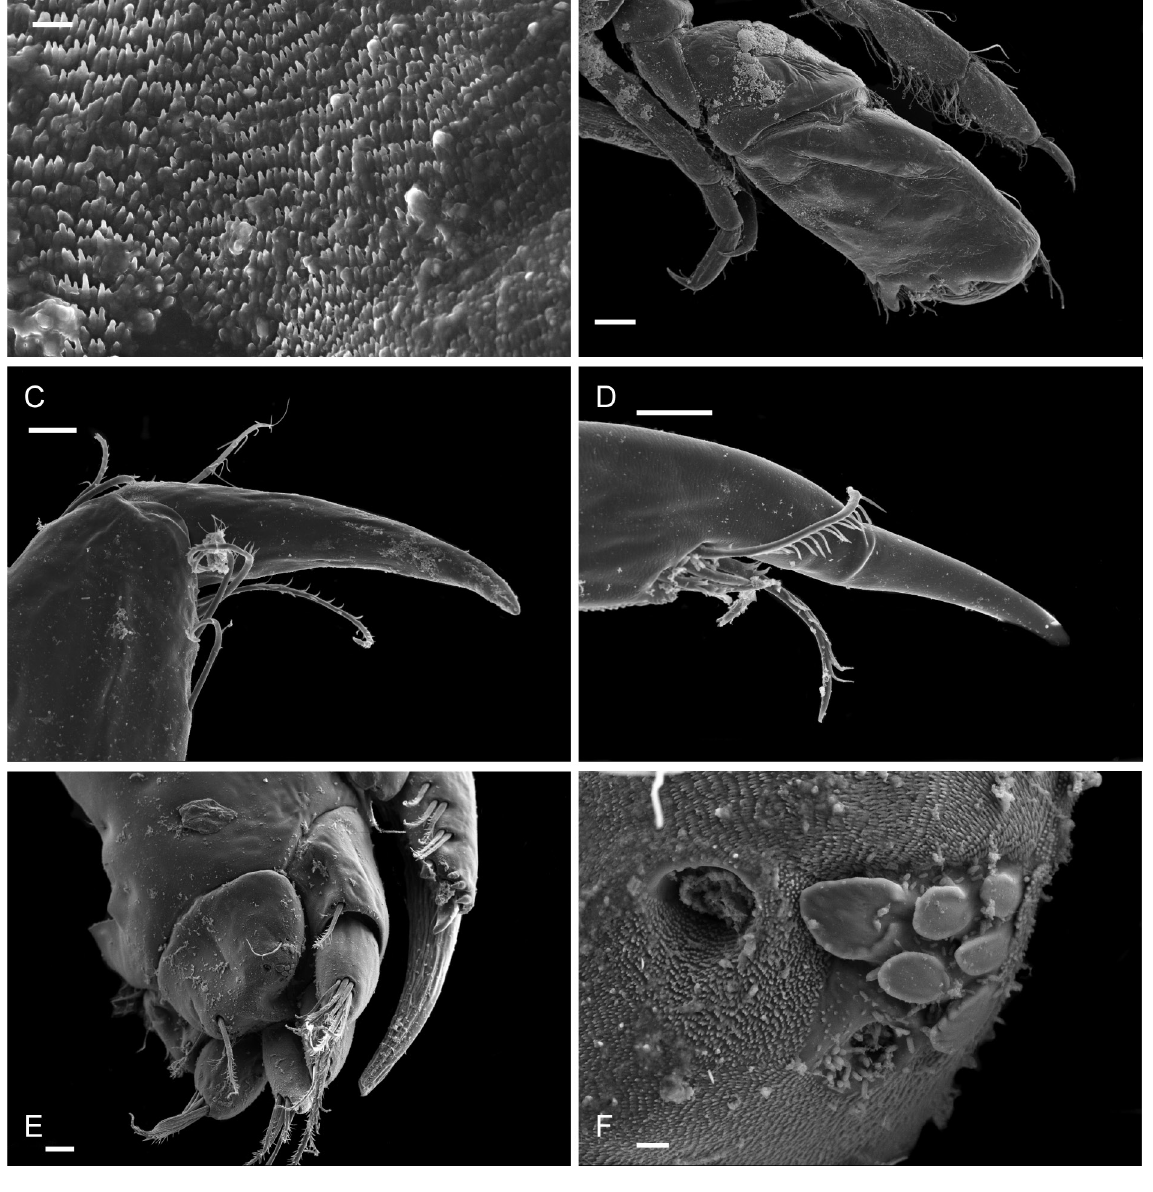
Fig. 8. Bryoconversor tutus gen. et sp. nov., paratype, ♂, NIWA 52919, 0.64 mm long. A . Detail of serrated surface on telson. B . Gnathopod 1 and larger gnathopod 2. C . Dactylus gnathopod 1. D . Dactylus gnathopod 1. E . Dorsal view telson, uropod 3 and uropod 2. F . Flat-topped projections on telson. Scale bars: A = 1 μm; B = 100 μ m; C-D = 10 μ m; E = 20 μ m; F = 2 μ